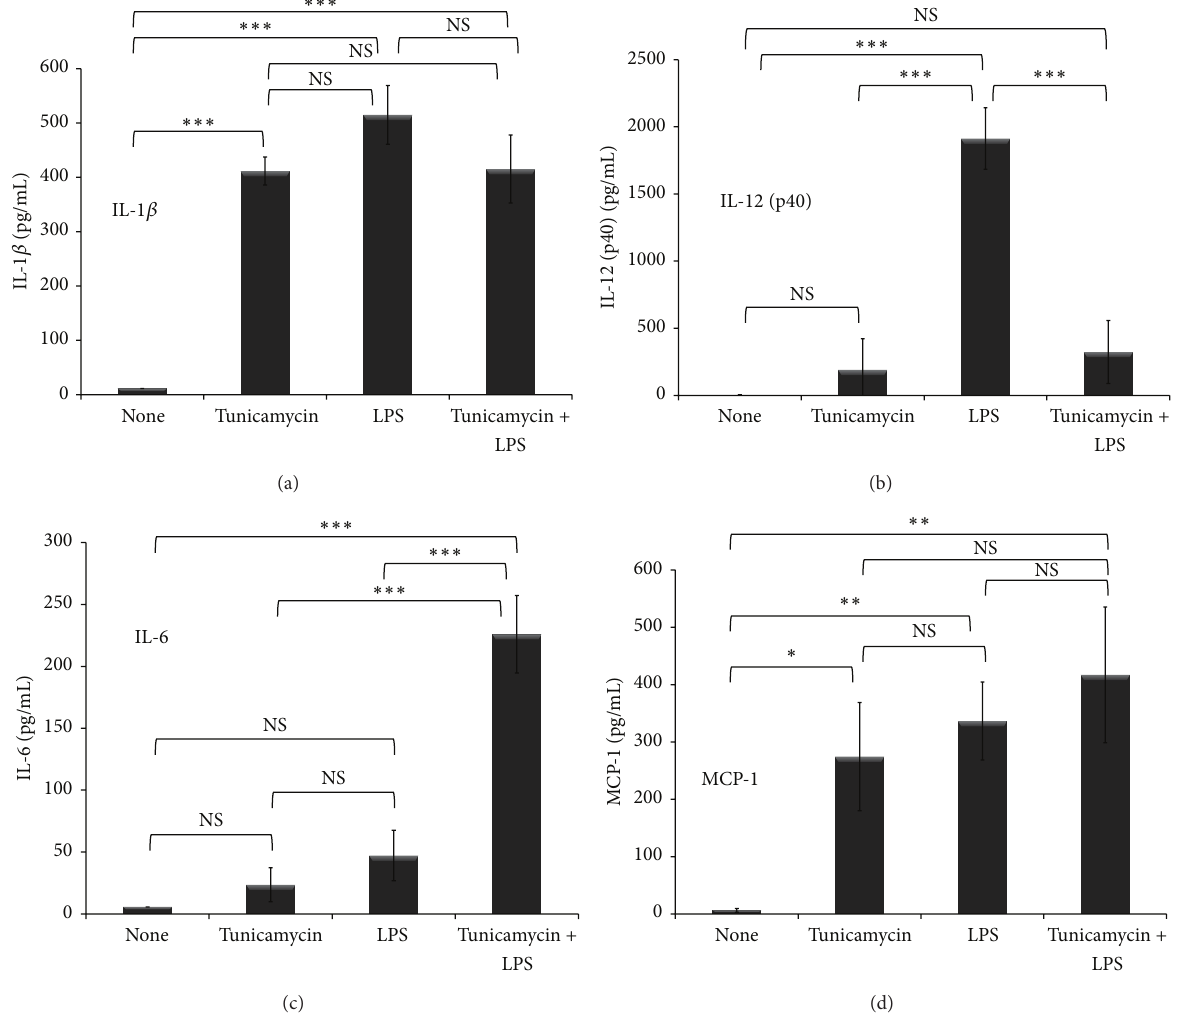
Figure 8: Induction of ER stress dysregulates LPS-induced inflammatory cytokine release. THP-1 cells ( 1 × 10 6 cells/mL) were treated with tunicamycin (10 𝜇 g/mL) or DMSO overnight prior to LPS exposure (40 ng/mL) for 6hr. Supernatants were collected and 50 𝜇 L was used to measure cytokine and chemokine release using the Luminex based magnetic bead assay (see Section 2). A selected panel of cytokine and chemokine release is presented. (a) IL-1 𝛽 , (b) IL-12p40, (c) IL-6, and (d) MCP-1. Error bars represent the SD from the mean of three independent experiments. 𝑃 values annotated ∗∗∗ 𝑃 < 0.0001 ; ∗∗ 𝑃 = 0.001 – 0.01 ; ∗ 𝑃 = 0.01 – 0.05 ; 𝑃 > 0.05 were not significant